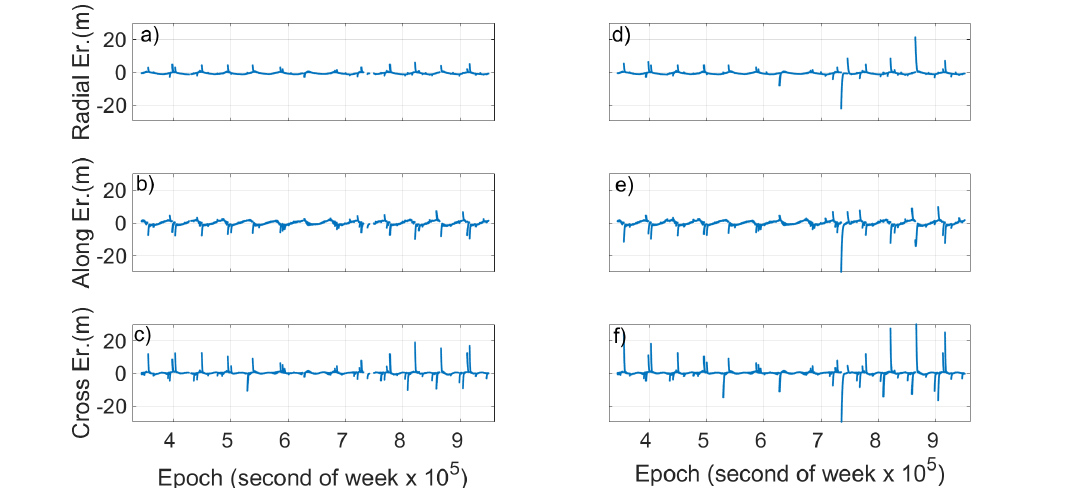
Figure 13. Comparison of radial, along and cross error for Milena (E14) obtained by using validity time threshold of: 1800 s ( left ); and 10,800 s ( right ). To have a better readability, the maximum value of errors is limited to 30 m. Errors that exceed this threshold relate to the cross component with a maximum error of 118.1 m ( f ). Figure refers to DOYs